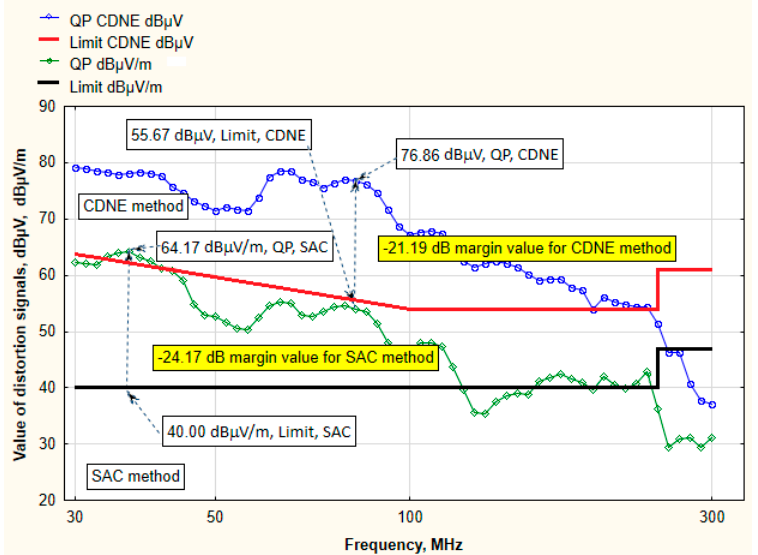
Figure 13. Recorded QP values using the new and traditional method against the allowable limits for the tested 18 W LED lamp D.